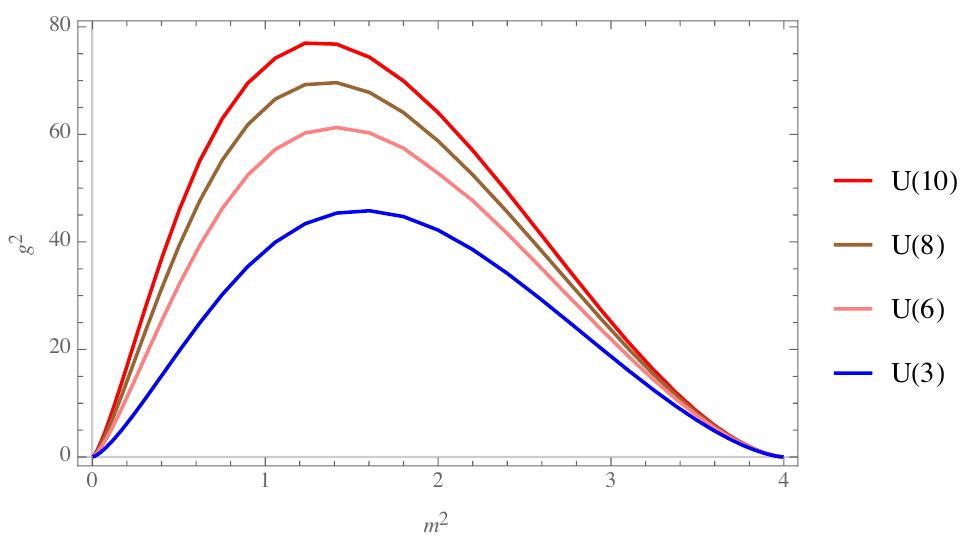
Figure 9 . Upper bound on the coupling to a bound state in the singlet channel in the presence of no others. The bound is increasing with N but g 2 =N is decreasing as it should.